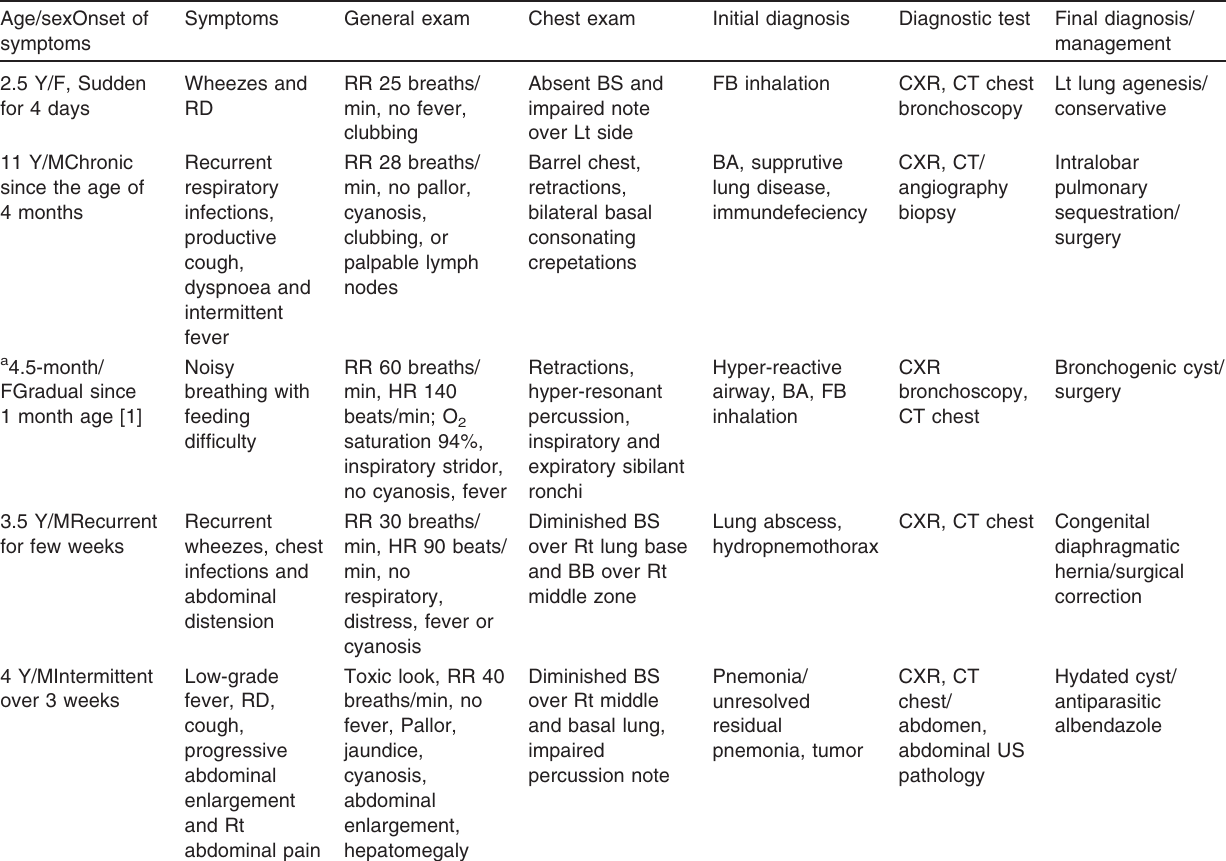
Table 1 A summary of our cases Age/sexOnset of